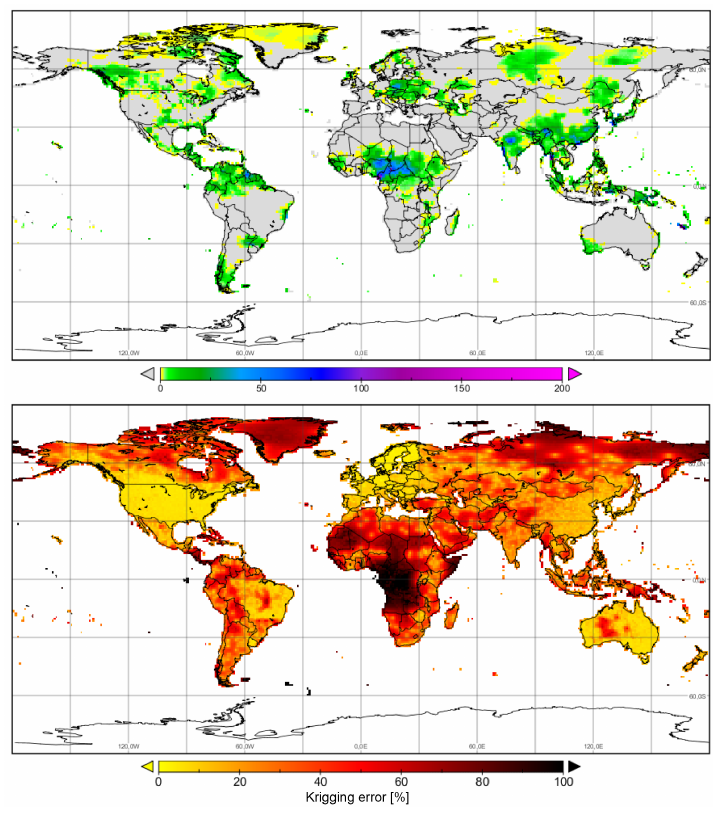
Figure 6. Precipitation analysis of 7 July 1997 (top panel) and corresponding interpolation (kriging) error field (bottom